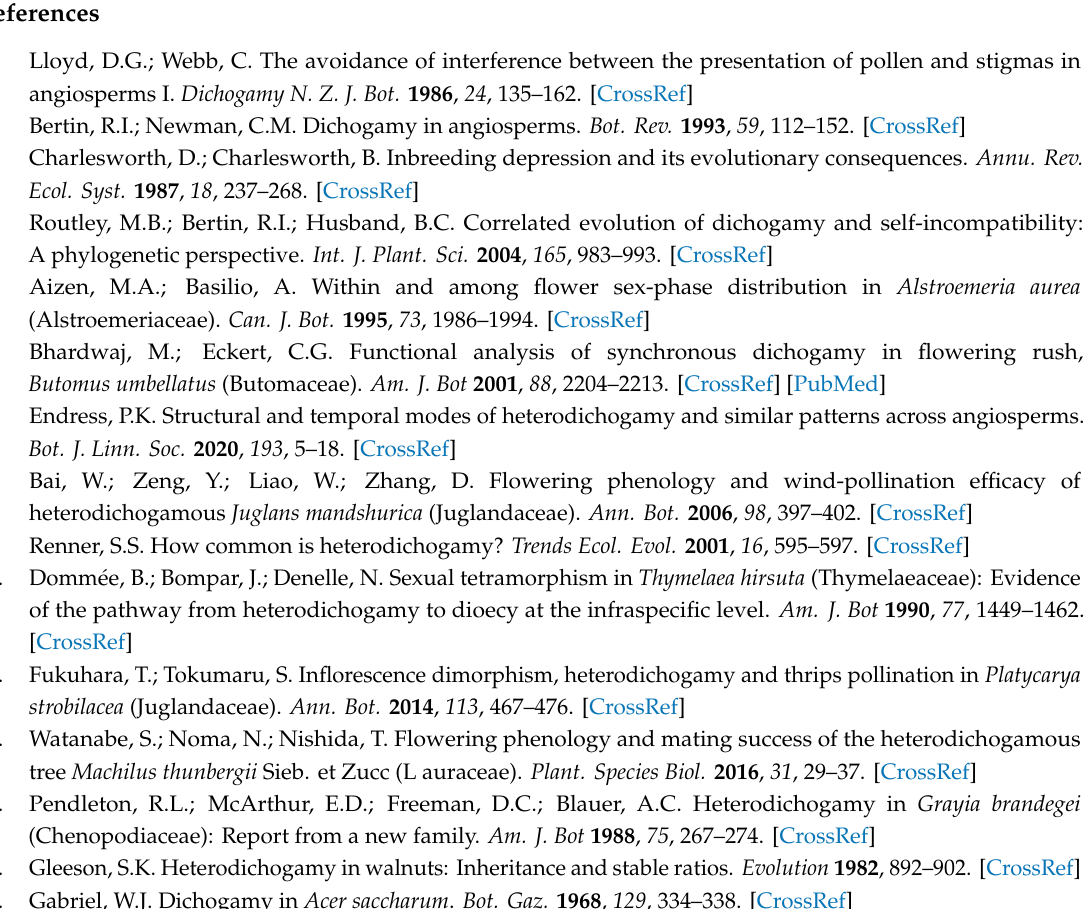
Figure A3. Mean relative humidity records, collected at 10-min intervals, for the dates on which flowering progression was monitored in 2018.